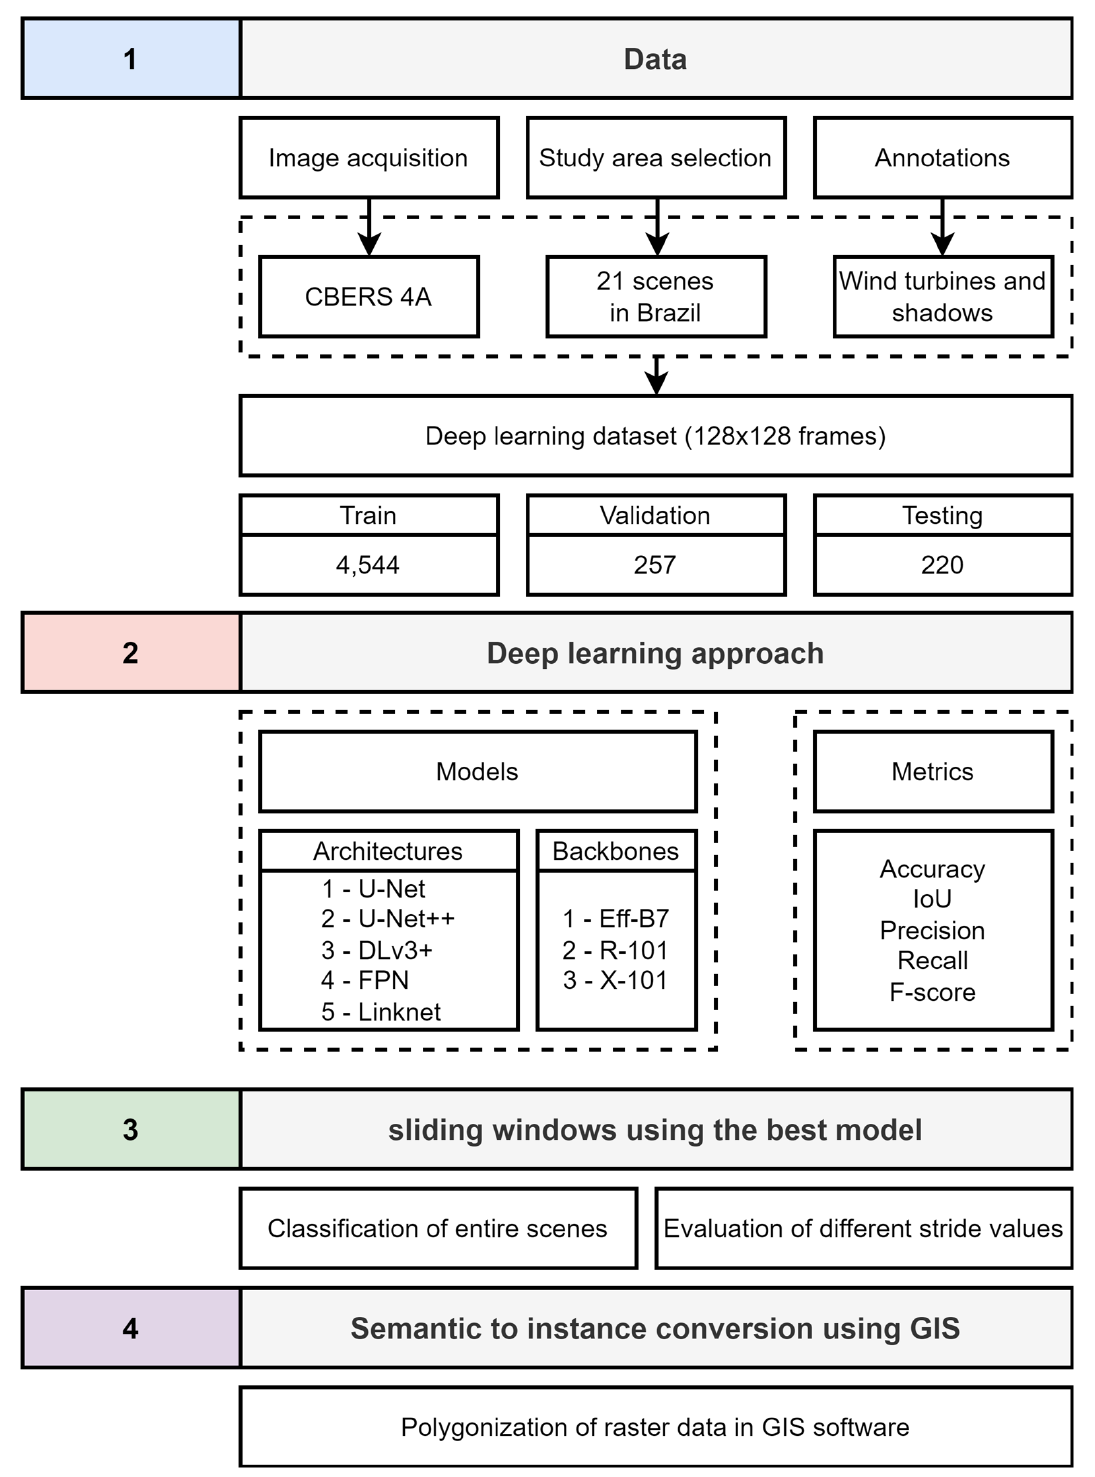
Figure 1. Methodological flowchart. The numbering corresponds to the subtopics of the section.